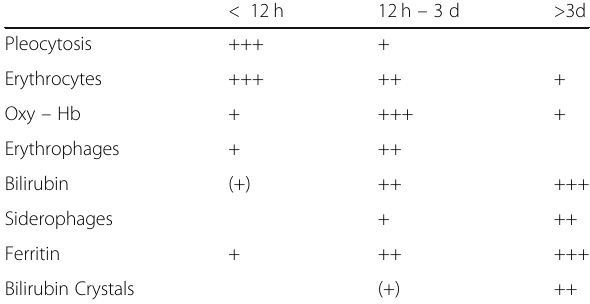
Table 19 Time course of various CSF alterations after SAH